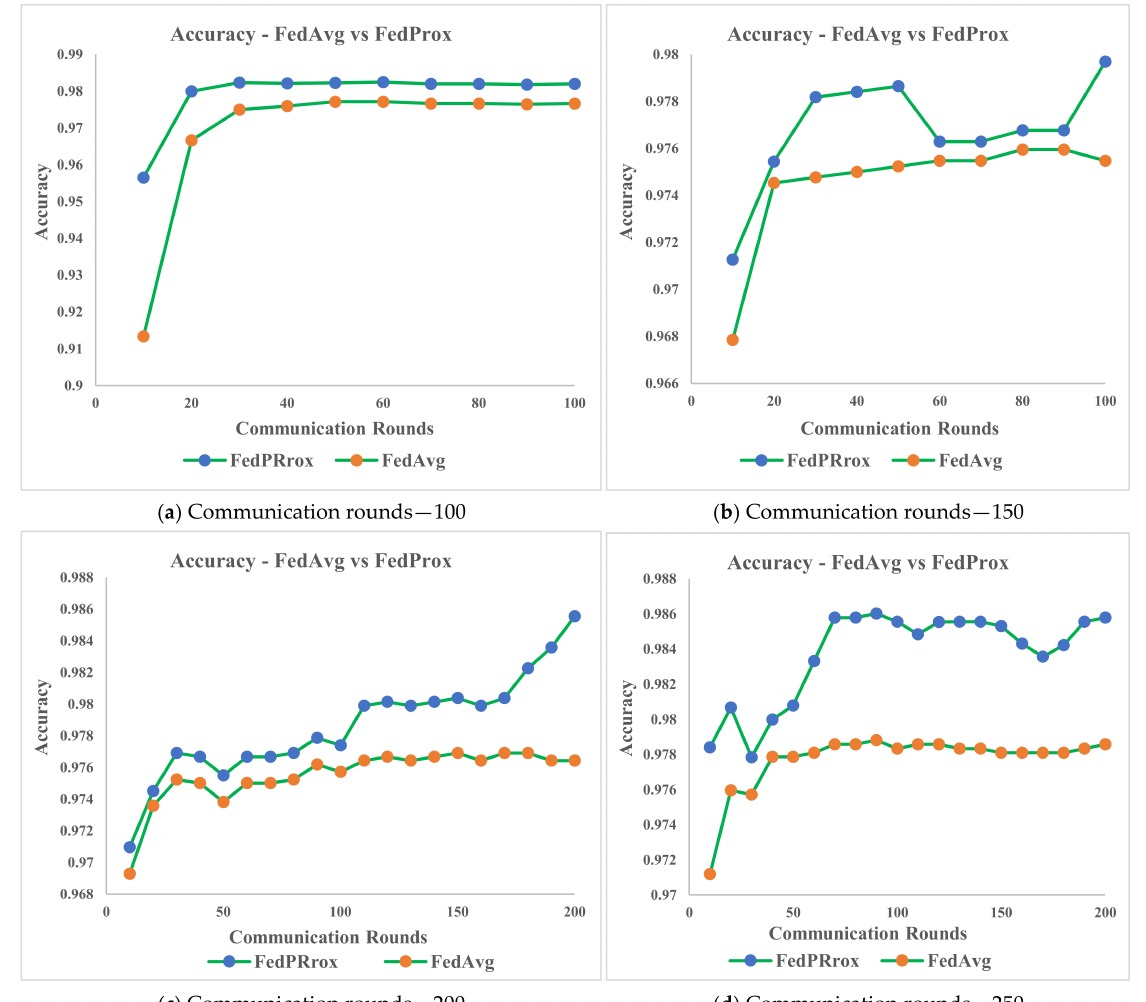
Figure 9. FedAVg vs.